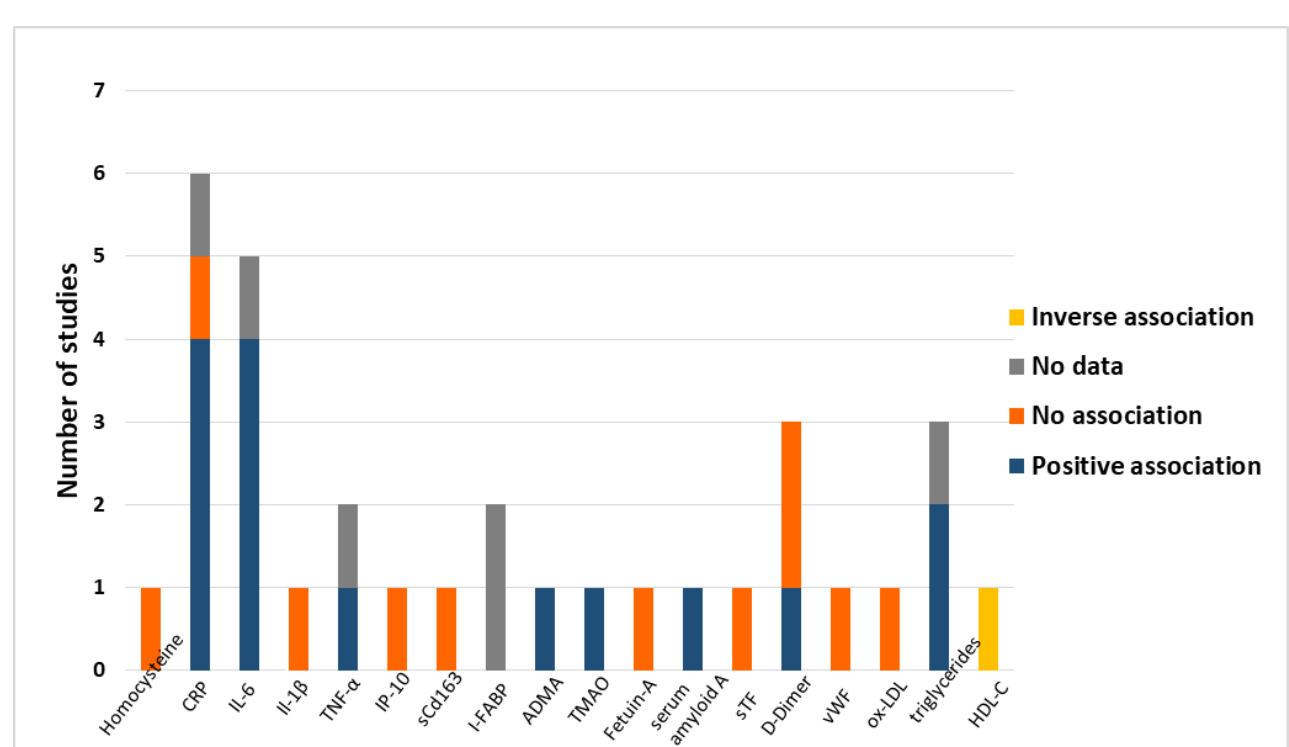
FIGURE 3 - Association between sCD14 microbial translocation biomarker and biomarkers of inflammation and cardiovascular risk. sCD14, soluble CD14; EndoCAb, endotoxin nucleus antibody; CRP, C-reactive protein; IL-6, interleukin-6; IL-1 β , interleukin 1 β ; TNF- α , tumor necrosis factor-alpha; IP-10, interferon- γ -inducible protein 10; sCD163, soluble CD163; I-FABP, intestinal fatty acid binding protein; ADMA, asymmetric dimethylarginine; TMAO, trimethylamine-N-oxide; sTF, soluble tissue factor; vWF, von Willebrand factor; oxLDL, oxidized LDL